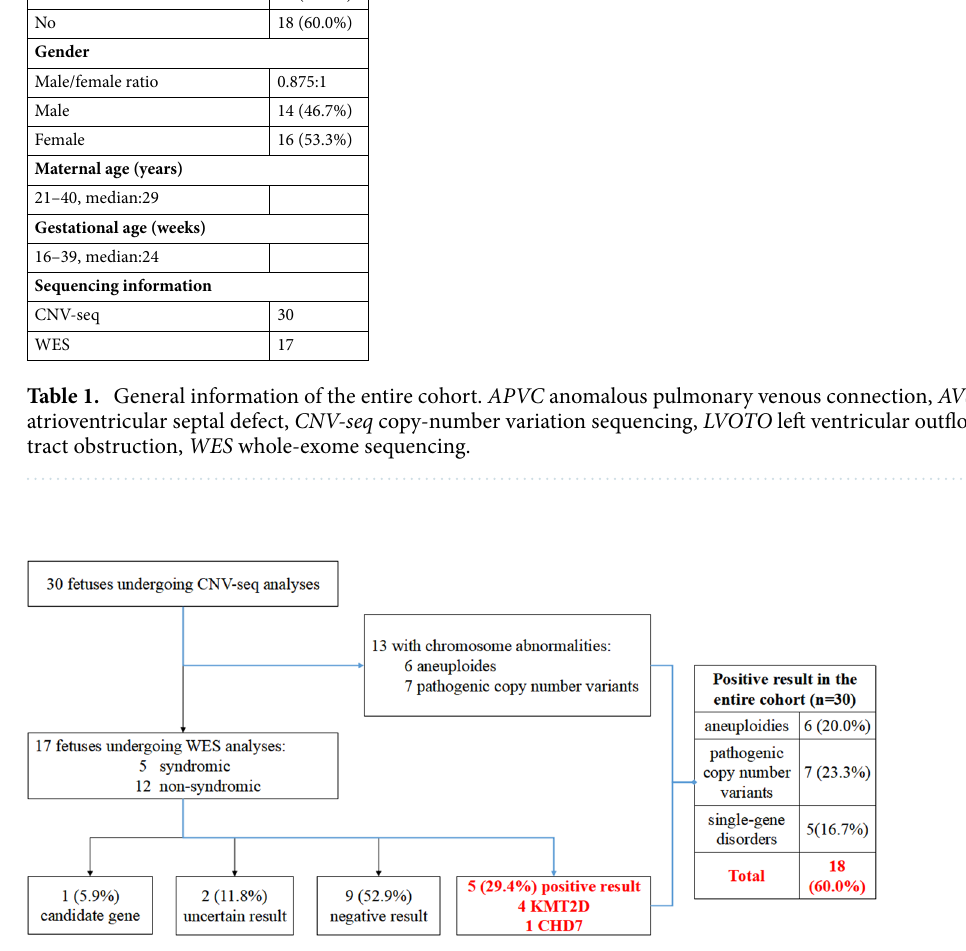
Figure 1. Flowchart showing the genetic testing and findings of next-generation sequencing analysis in the study of fetal congenital heart disease with aberrant right subclavian artery. In this cohort, ‘syndromic’ and ‘non- syndromic’ refer to presence and absence, respectively, of fetal structural abnormalities detected on ultrasound. CNV copy-number variant, CNV-seq CNV sequencing, WES whole-exome sequencing.